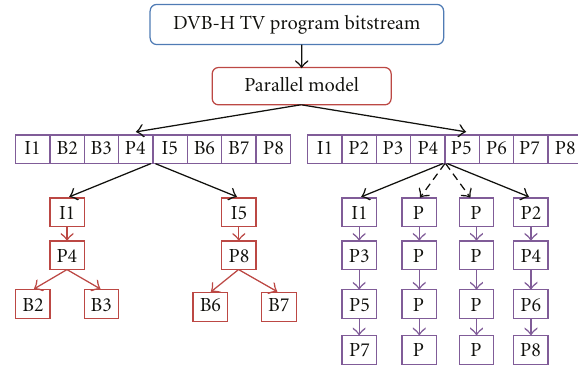
Figure 10: Parallel Decoding